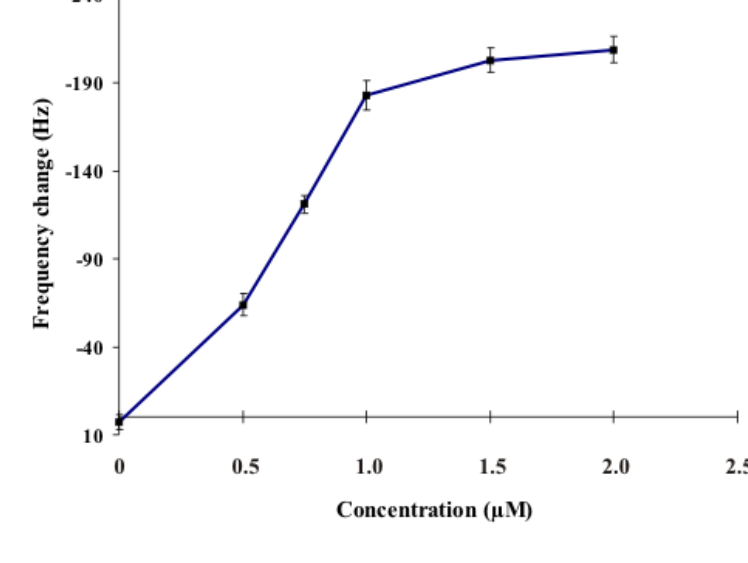
Figure 1. Resonant frequency changes of quartz crystal by thiol-modified oligonucleotide probe immobilization. Frequency changes were represented by the frequency differences between the frequency value of thiol-modified oligonucleotide probe immobilized on gold electrode (F1) and frequency value of original quartz crystal (F0) before immobilization ( ∆ F = F0-F1). Each data point represents the mean ± SD (n =